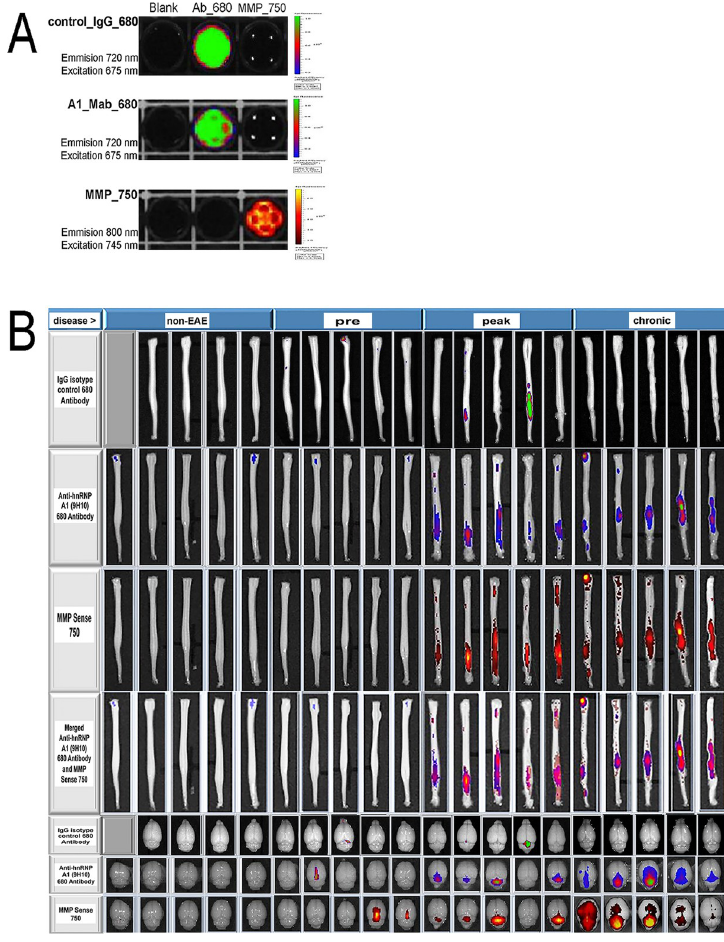
Fig 1. In vitro and ex vivo detection of control_IgG_680, A1_Mab_680 and MMP_750 fluorescence by IVIS imaging in EAE. (A) In vitro assessment of control IgG_680 shows a signal at the appropriate wavelength (row 1). In experiments that used both MMP_750 and A1_Mab_680 fluorescence in the same animal, there was no overlap in signal (rows 2 and 3). (B) In vivo imaging: four groups of mice (non-EAE, pre-disease, peak disease and chronic disease) were injected with either control_IgG_680 (rows 1 and 5) or A1_Mab_680 and MMP_750 (rows 2–4, 6 and 7) 24 hours prior to sacrifice. Clinical scores were obtained on the day of sacrifice. Row 1: Spinal cord control_IgG_680 imaging shows signal in two of five animals at the peak disease stage and marginal signal at other time points. Row 2: Spinal cord A1_Mab_680 imaging shows signal predominantly at the peak and chronic stages of EAE. Row 3: Spinal cord MMP_750 imaging closely parallels the A1_Mab_680 imaging. Row 4: Merged images of rows 3 and 4 show overlap between A1_Mab_680 and MMP_750 and a caudal to rostral shift of both signals. Row 5: Brain control_IgG_680 imaging shows modest signal in the same animals as the spinal cord imaging. Rows 6 and 7: Brain A1_Mab_680 and MMP_750 imaging (respectively) show increased signal in brain. wavelength of 720 nm, both the control_IgG_680 and A1_Mab_680 were detected. In experi- ments that utilized both MMP_750 and A1_Mab_680 in the same animals, the two dyes were measured by IVIS scan simultaneously with different filter sets to assure the fluorescent signals did not interfere with each other. At an excitation wavelength of 745 nm and an emission wave- length of 800, MMP_750 (Fig 1A) was detected, whilst A1_Mab_680 was not. Similarly, at an excitation wavelength of 675 nm and an emission wavelength of 720 nm, the A1_Mab_680 was detected (Fig 1A) and the MMP_750 was not. Thus, each dye was detected at its respective wavelength without an overlapping signal.